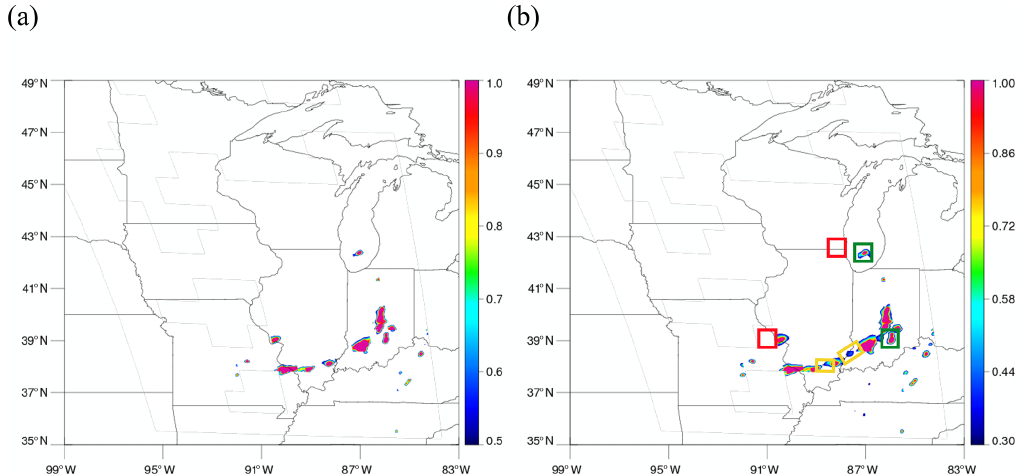
Figure 5. Predicted convective regions by the model using a threshold of (a) 0.5 and (b) 0.3. Colors represent a scale of being convective (1 being convective and 0 being non-convective). The colored boxes in panel (b) indicate six scenes selected for further study, namely two scenes that are correctly identified as convection (green boxes), two scenes detected using the threshold of 0.3 but not of 0.5 (yellow boxes), and two scenes missed at both thresholds (red